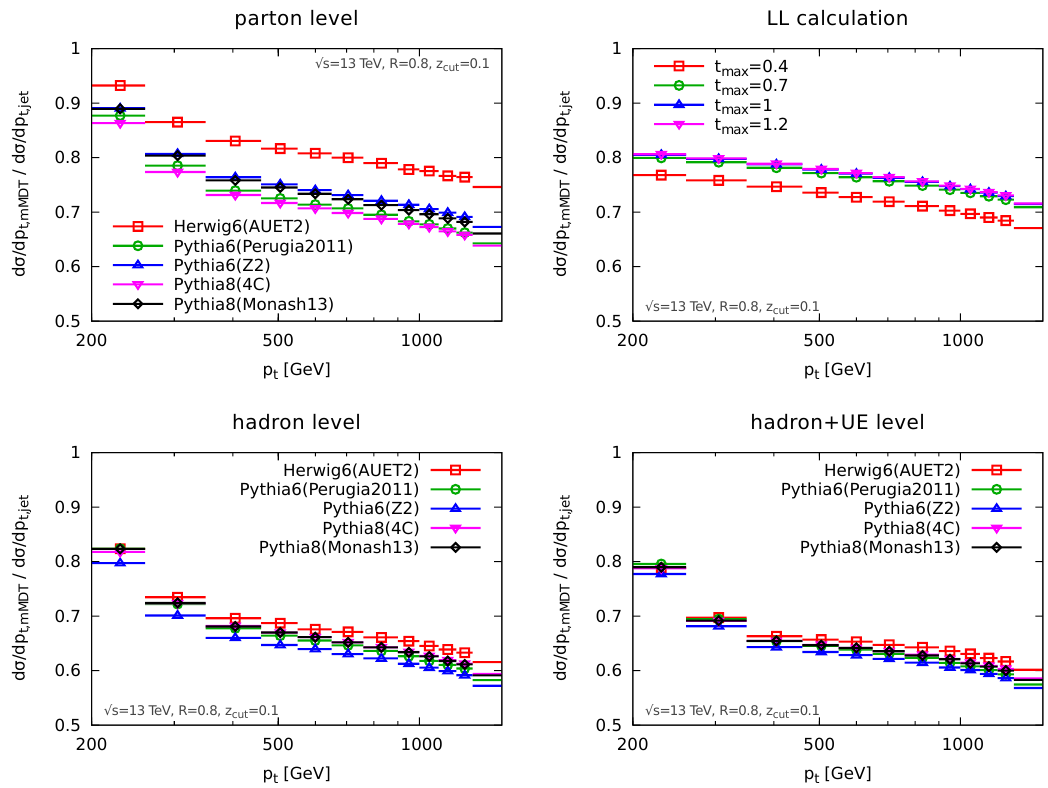
Figure 16 . Ratio of the jet cross-section d(cid:27)=dp t; mMDT , binned in the groomed jet p t , to the stan- dard jet cross-section d(cid:27)=dp t; jet . The results of Monte-Carlo simulations performed with di(cid:11)erent generators and tunes are shown in the top-left, bottom-left and bottom-right plots, respectively for simulations at parton-level, hadron-level without UE, and hadron-level including UE. The top-right plot instead shows our LL analytic results.